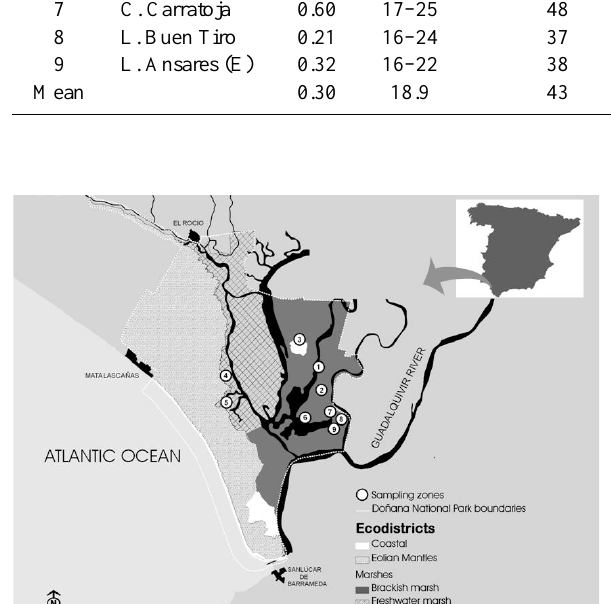
Fig. 1. Map of the study area showing the location of the study sites and the major ecological districts in the Do˜nana Park, SW